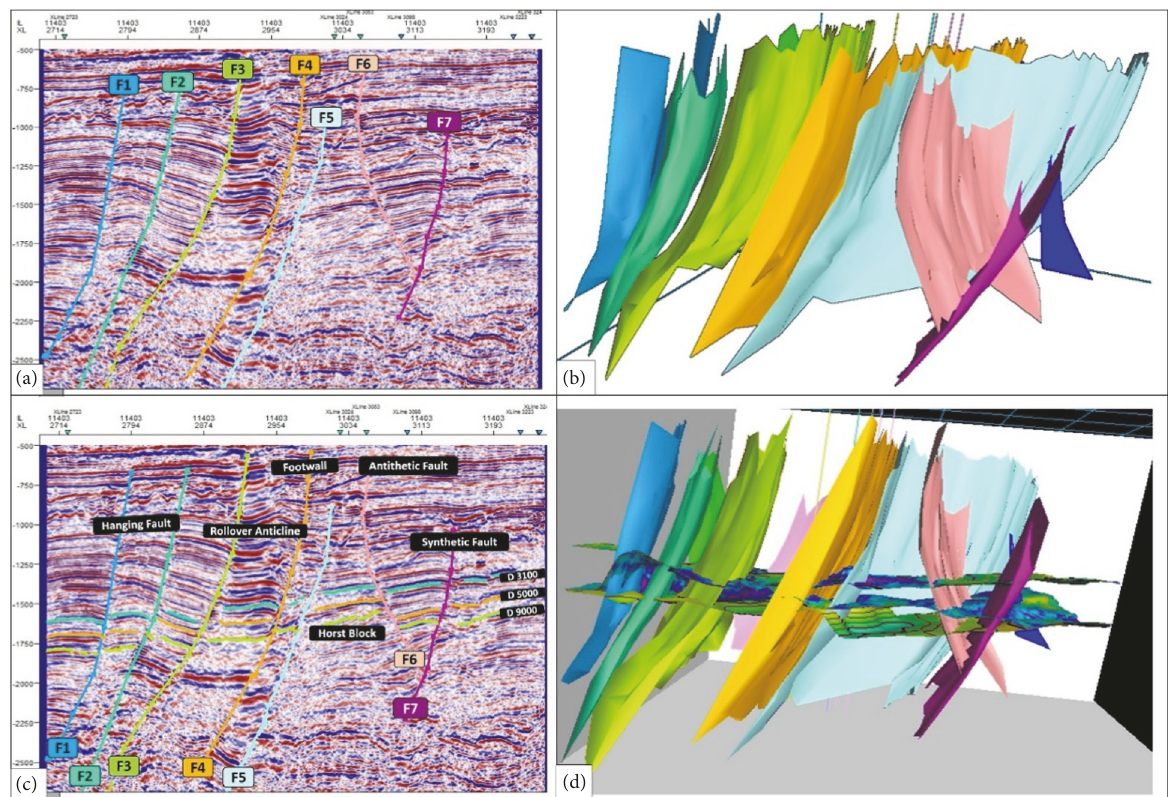
Figure 5: (a) Interpreted seismic section showing near listric faults. (b) 3D window showing structural framework generated from faults. (c)Faultinterpretationshowing various structuralstyles and mapped reservoir surfaces (D3100, D5000, and D9000). (d) 3D window showing structural and stratigraphic framework generated from faults and